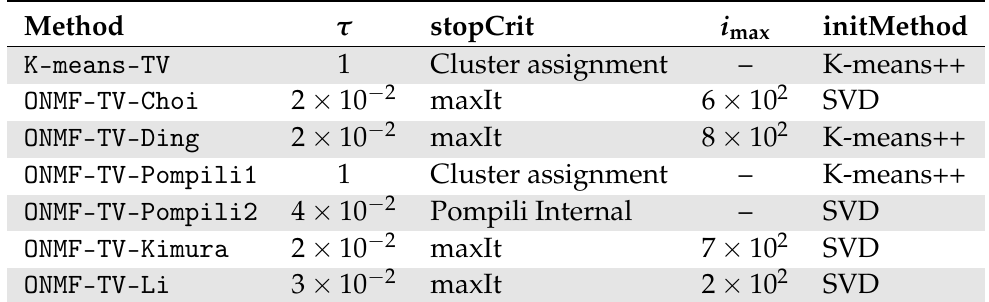
Table A1. Parameter choice of the separated methods for the numerical experiments with the MALDI